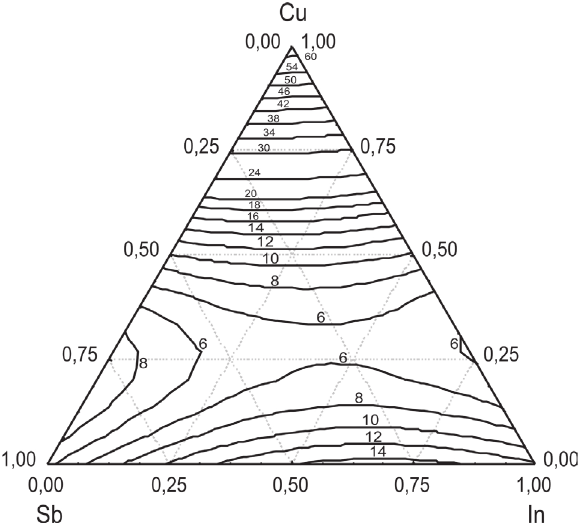
Figure 6. Iso-lines of electric conductivity for the ternary Cu-In-Sb